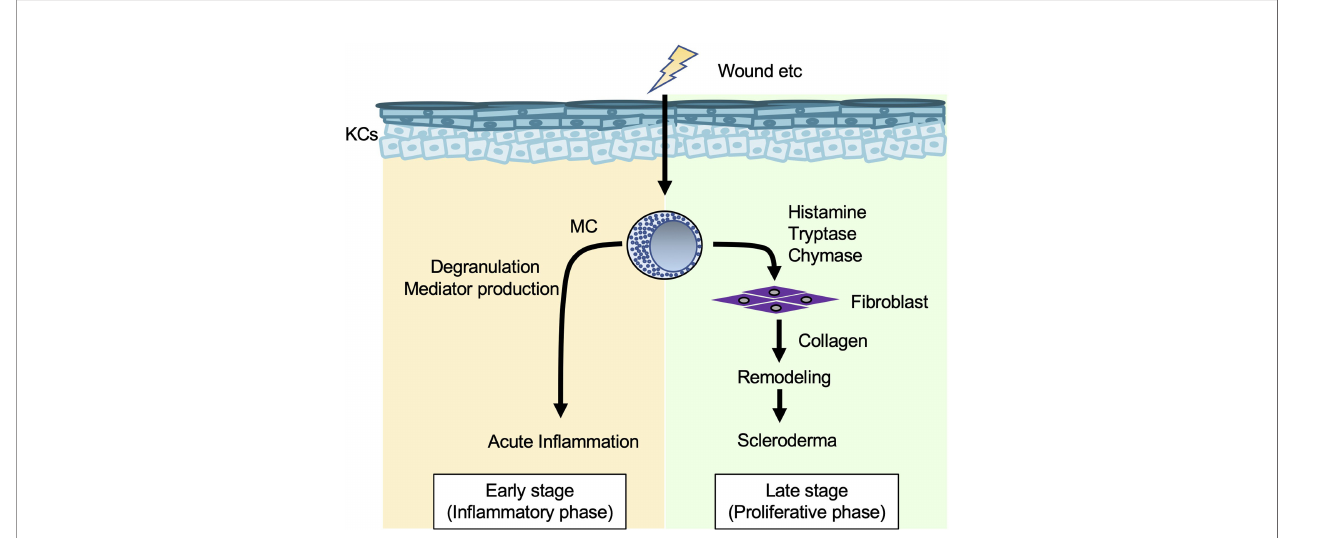
FIGURE 5 | Mast cells in collagen synthesis (wound healing and fi brosis). When the skin is wounded, mast cells (MCs) degranulate and release various mediators that enhance vascular permeability and recruitment of in fl ammatory cells to injured sites in the early stage (in fl ammatory phase). In addition, MC-derived histamine, tryptase and chymase induce fi broblasts to produce collagen, which is involved in tissue remodeling and development of scleroderma in the late stage (proliferative